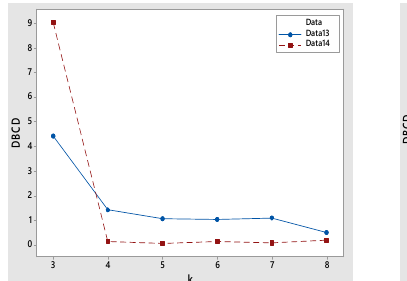
Fig. 7. Scatter plot for distance between cluster centroids (DBCD) vs k for Data13-Data14